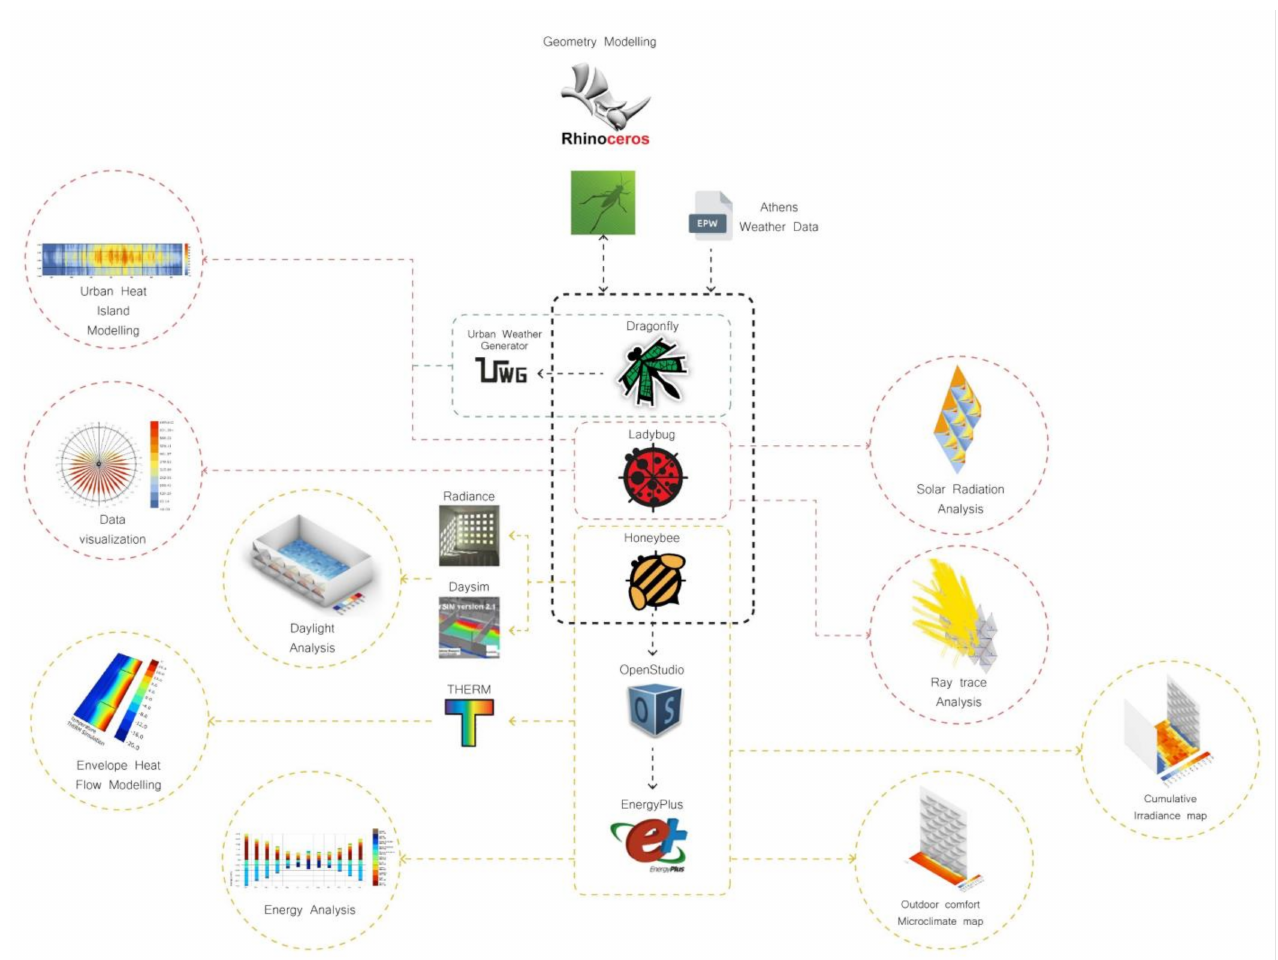
Figure 1. Overview of the digital tools workflow in the Grasshopper environment, highlighting the main plug-ins (Ladybug, Honeybee, Dragonfly) and energy simulation engines (OpenStudio, EnergyPlus, Radiance, DaySim, THERM), as well as the individual study